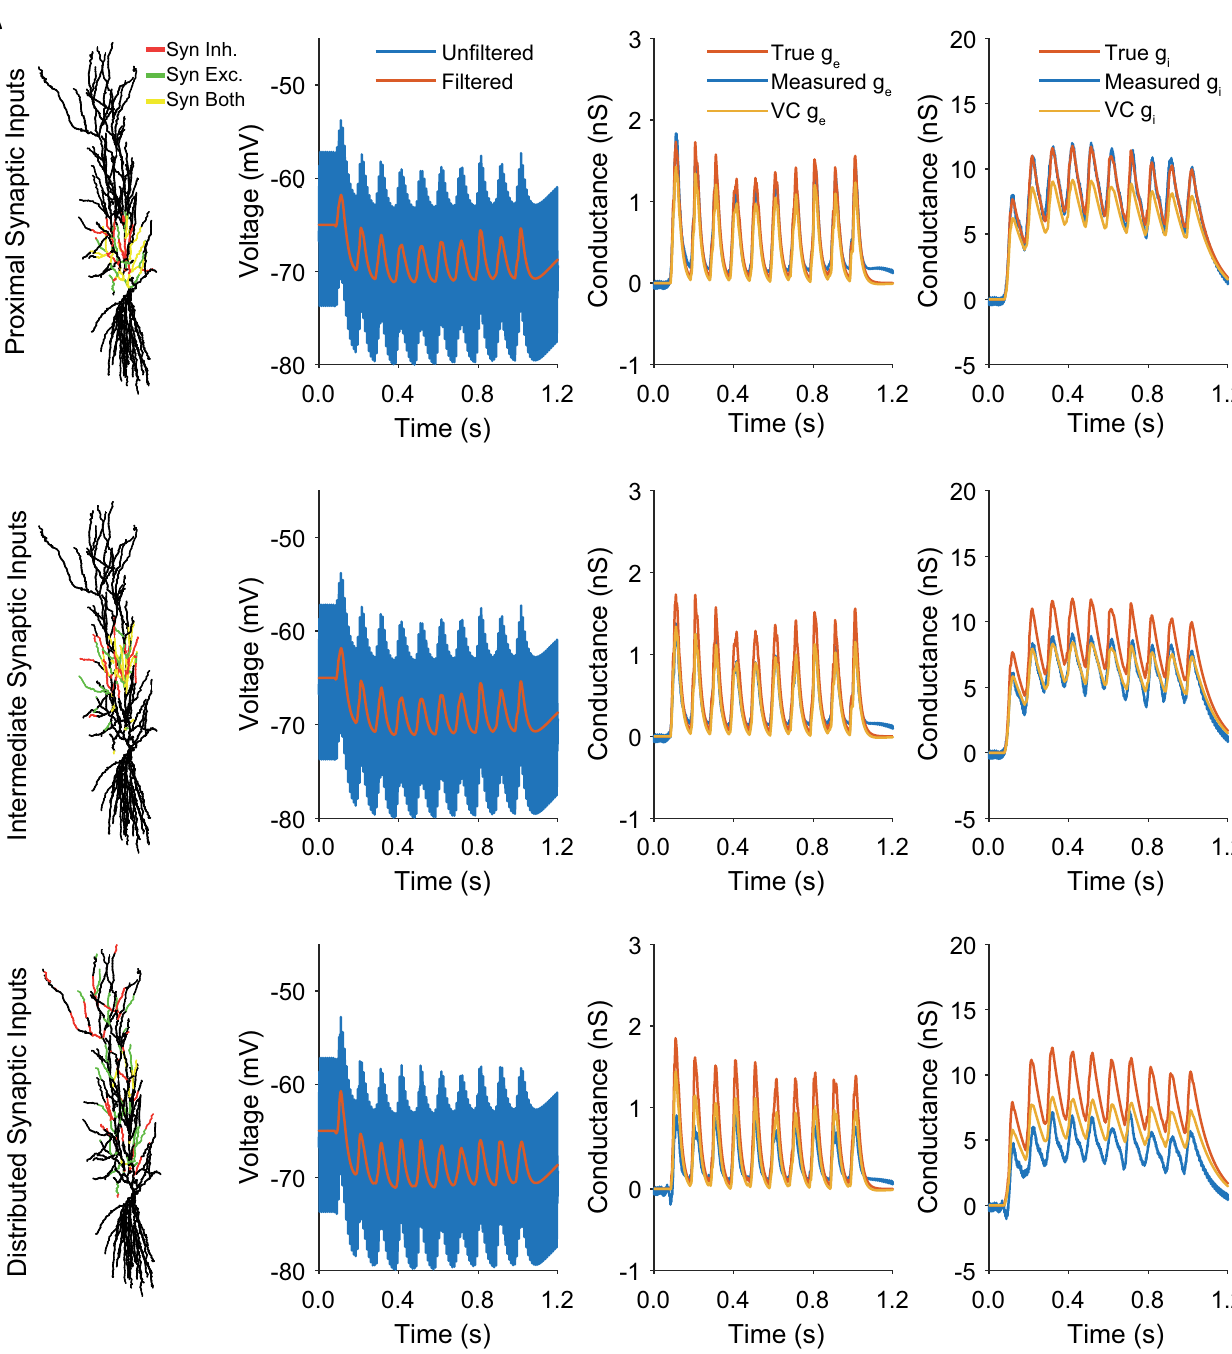
Fig 9. Measuring conductance changes of dendritic synapses. A. Inhibitory and excitatory synapses were placed proximal (129.92 μ m ± 47.83 μ m SD) to the soma and all measurements were performed at the soma. Simultaneous conductance measurements are at least as accurate as separate voltage clamp recordings for these proximal synapses. B. Inhibitory and excitatory synapses were placed at intermediate distance (238.69 μ m ± 39.71 μ m SD). Simultaneous conductance measurements and voltage clamp are both well correlated with the temporal dynamics but underestimate the amplitude. C For distributed synapses (309.92 μ m ± 164.46 μ m SD) simultaneous conductance measurements underestimate the magnitude of the true conductance but still follow the time